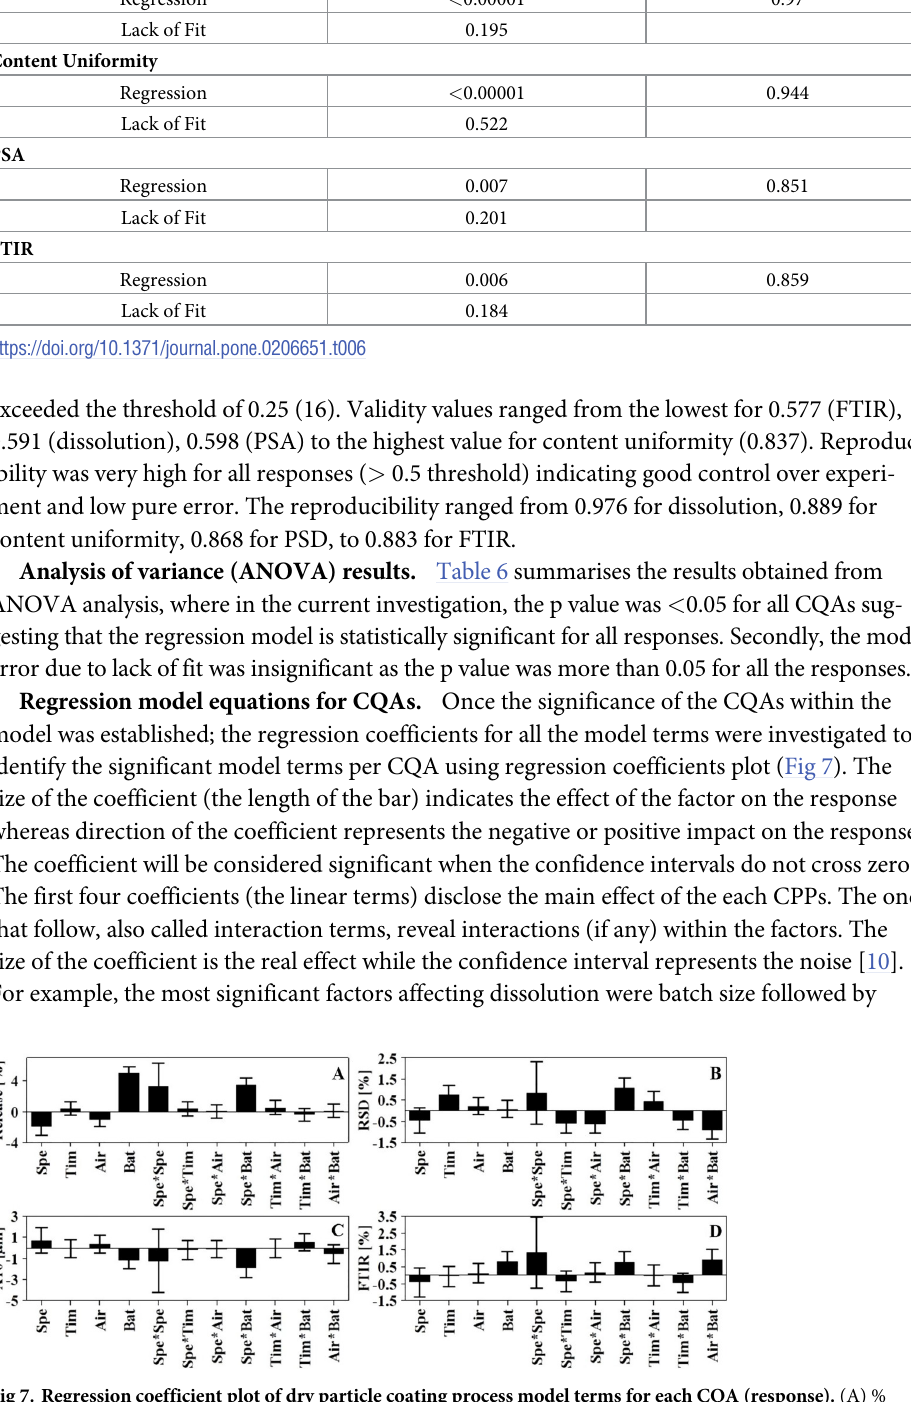
Fig 7. Regression coefficient plot of dry particle coating process model terms for each CQA (response). (A) % release in 60 minutes, (B) %RSD, (C) X 10 value ( μ m) and (D) FTIR spectrum.